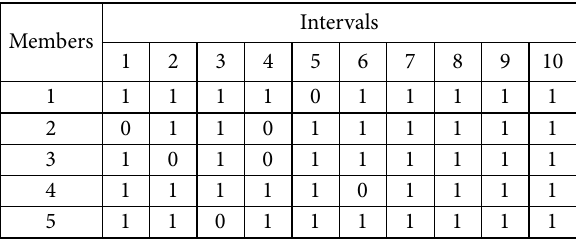
Table 8. The availability matrix of